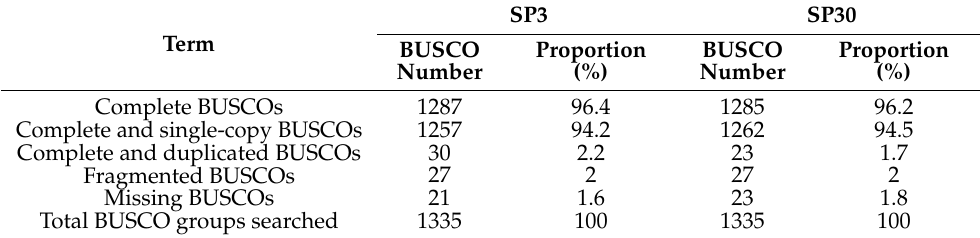
Table 2. BUSCO analysis results of the two Lentinula edodes